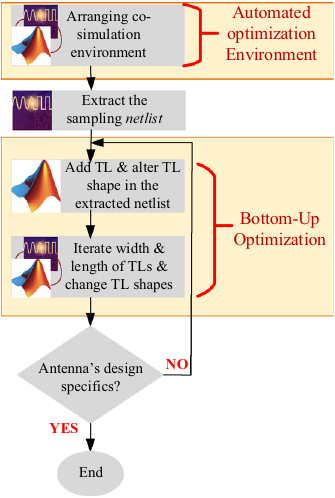
Figure 1. Flowchart of employed BUO method for primarily configuring the antenna